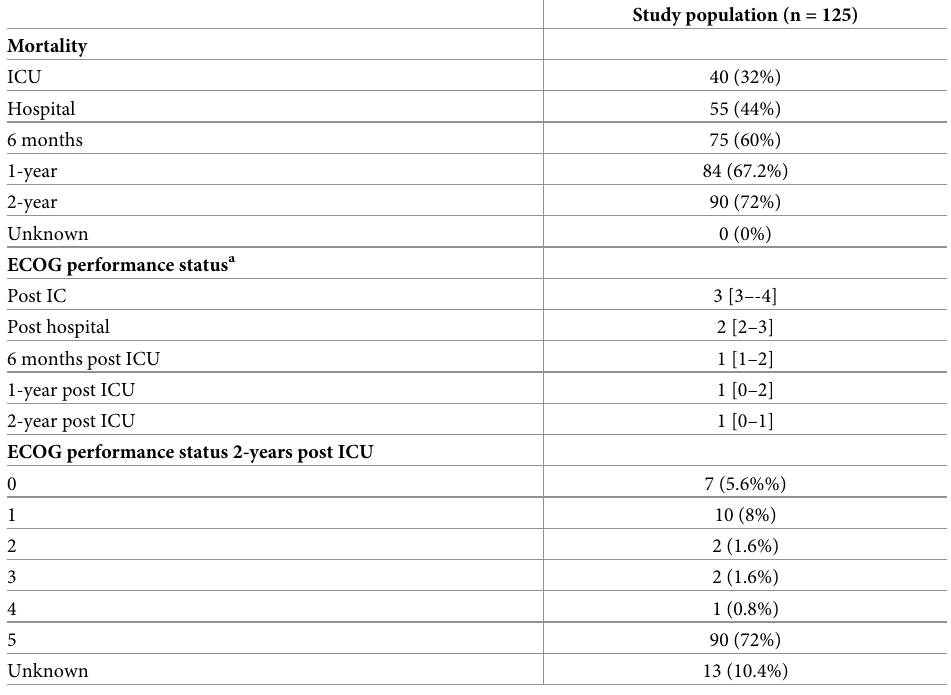
� Categorical variables: Mean (%). Continuous variables: Mean (standard deviation) for normally distributed data, skewed distribution, median [25th–75th IQR].